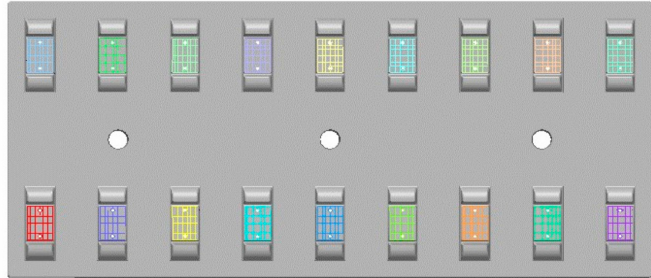
Figure 8. Track slab model and the establishment of bearing surface features.